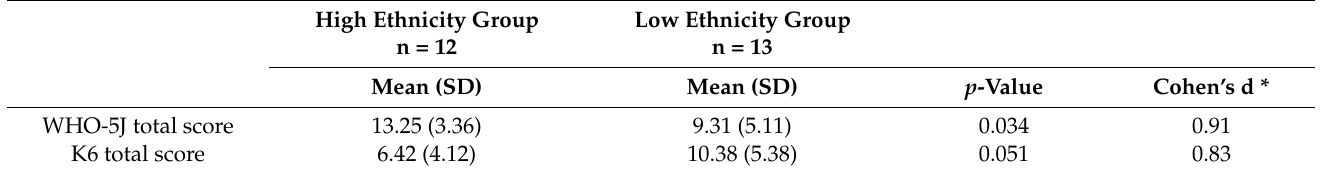
Table 2. Comparisons of WHO-5J and K6 scores between high and low ethnicity groups (n = 25). High Ethnicity Group Low Ethnicity Group n = 12 n = 13 Mean (SD) Mean (SD) p -Value Cohen’s d * WHO-5J total score 13.25 (3.36) 9.31 (5.11) 0.034 0.91 K6 total score 6.42 (4.12) 10.38 (5.38) 0.051